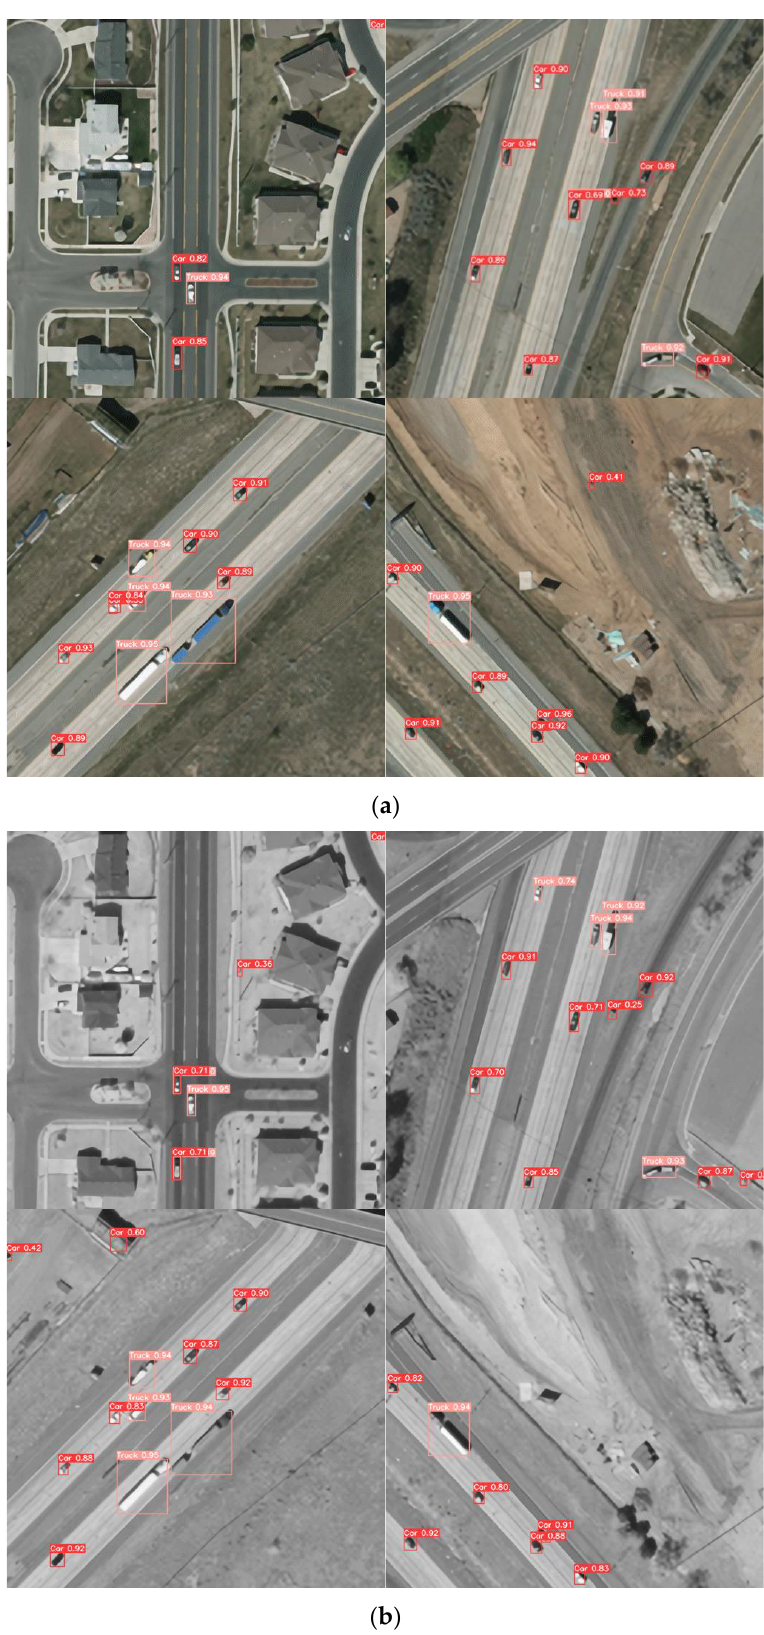
Figure 9. Visual results of detection performance on aerial images on VEDAI dataset: ( a ) VEDAI- VISIBLE, and ( b ) VEDAI-IR.